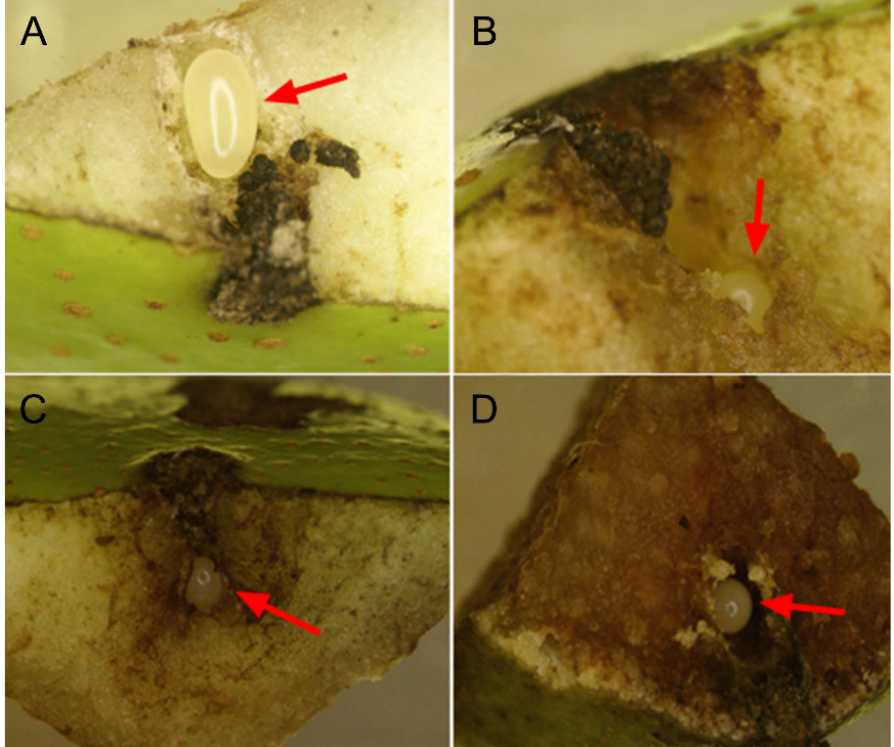
Figure 3. Egg chambers of R. foveipennis after oviposition: ( A ) egg laid after 2 days, ( B , C ) chamber filled with callus with crushed egg in treatment A after 5 days, ( D ) normal chamber with intact egg in treatment B after 5 days. Red arrow in each photo indicates the position of an egg. The larval survival rates on days 10, 20, and 30 in treatment A were 50% ( n = 8), 50% ( n = 4), and 50% ( n = 4), in 2013, respectively, and 87.5% ( n = 32), 55.6% ( n = 18), and 27.3% ( n = 11) in 2018. The larval survival rates on days 10, 20, and 30 in treatment B were 87.7% ( n = 57), 92.0% ( n = 50), and 75.7% ( n = 37) in 2013, and 100% ( n = 22), 100% ( n = 10), and 96.4% ( n = 28) in 2018 (Figure 4).